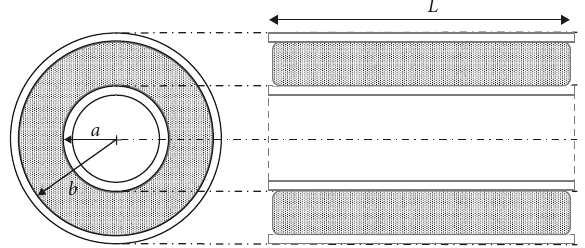
Figure 5: Nomenclature used for the static stiffness formulas where a represents the inner radius, b represents the outer radius, and L represents the length of the